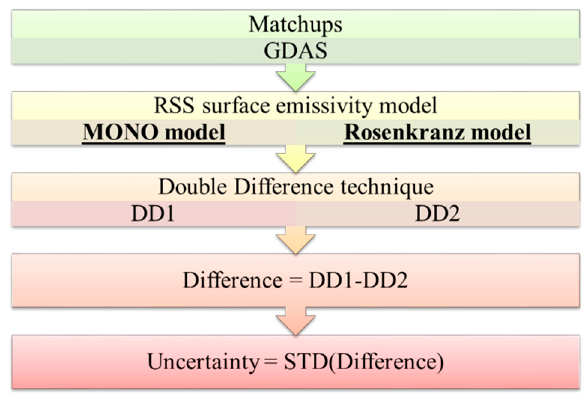
Figure 5. Diagram of uncertainty estimation procedure for the discrepancy in two different atmospheric absorption models: Rosenkranz and Mono. Table 4. Standard uncertainty for Mono and Rosenkranz model discrepancy.